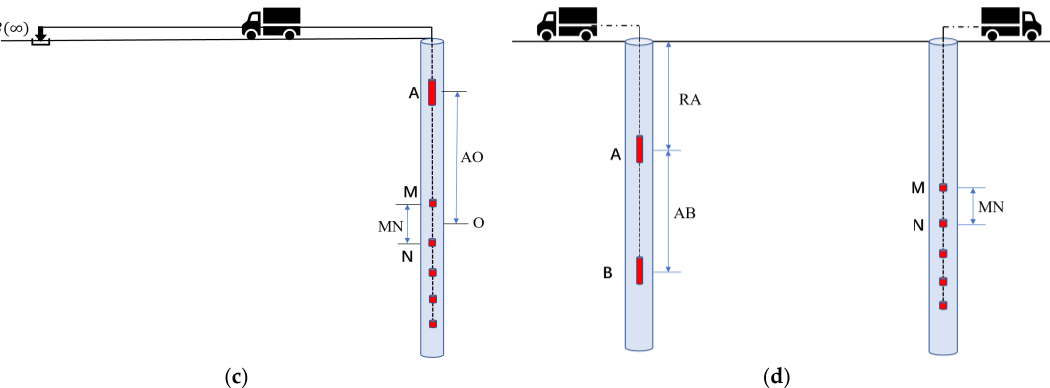
Figure 1. Borehole induced polarization mode: ( a ) Surface-borehole mode; ( b ) Borehole-surface mode; ( c ) Single-borehole method;( d ) Double-borehole method.